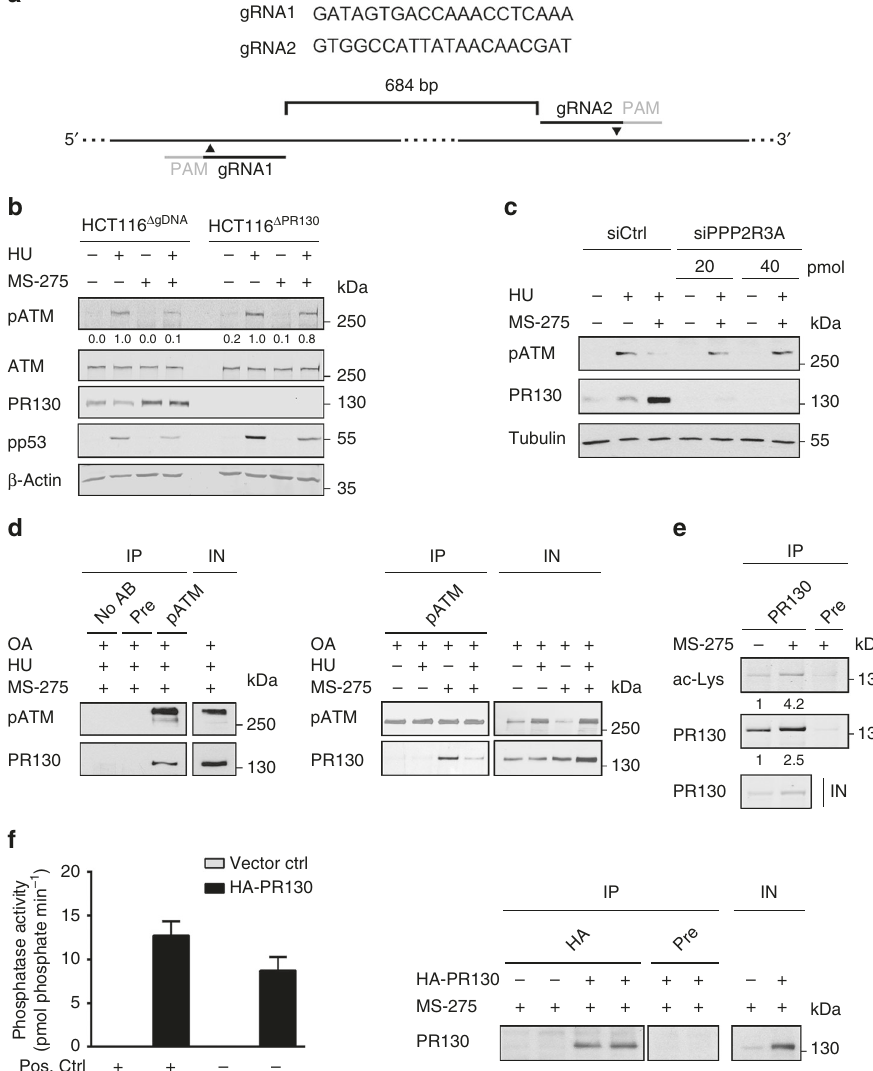
Fig. 6 PR130 expression antagonises ATM phosphorylation. a Schematic of PPP2R3A knockout using CRISPR-Cas9 technology. Humanised S. pyogenes Cas9 nuclease was expressed in HCT116 cells with two guide RNAs (gRNA) to introduce two DSB into the PPP2R3A gene (684 bp apart) as described in the Methods section. The usage of two cleavage sites increased the chances to create a successful knockout. b HCT116 Δ gRNA and HCT116 Δ PR130 (clone #16) cells were cultured with 2 µ M MS-275 and/or 1 mM hydroxyurea (HU) for 24 h. ATM, pATM (S1981), p53, pp53 (S15) and PR130 were detected